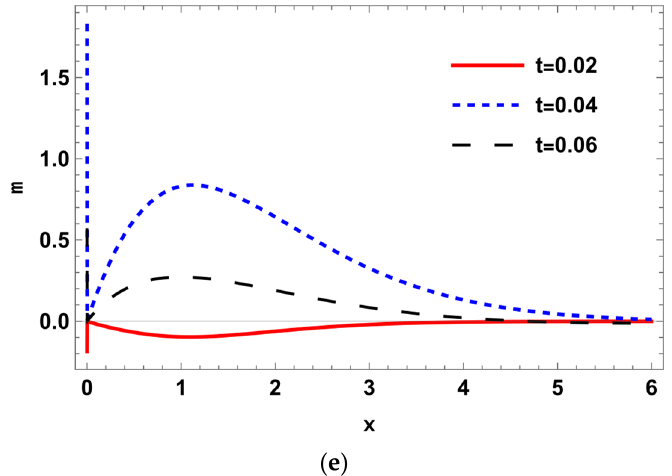
Figure 1. ( a – e ) The deterministic temperature, normal stress, carrier density, displacement, and moisture distributions along the distance for various values of times in relation to generalized photo-thermoelasticity theory.